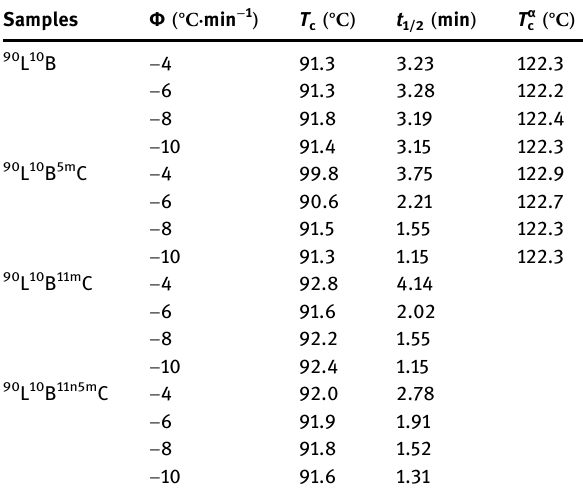
based on the PLA crystallization shown in Figure 1b.